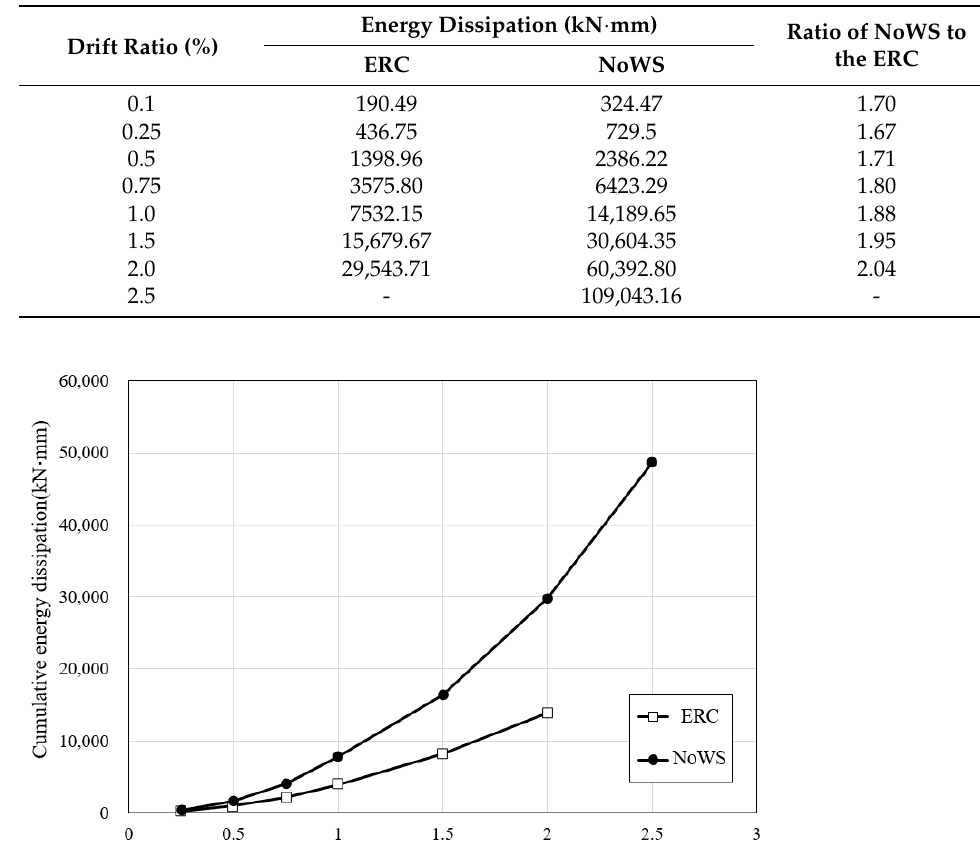
Table 6. Energy dissipation capability in each specimen.